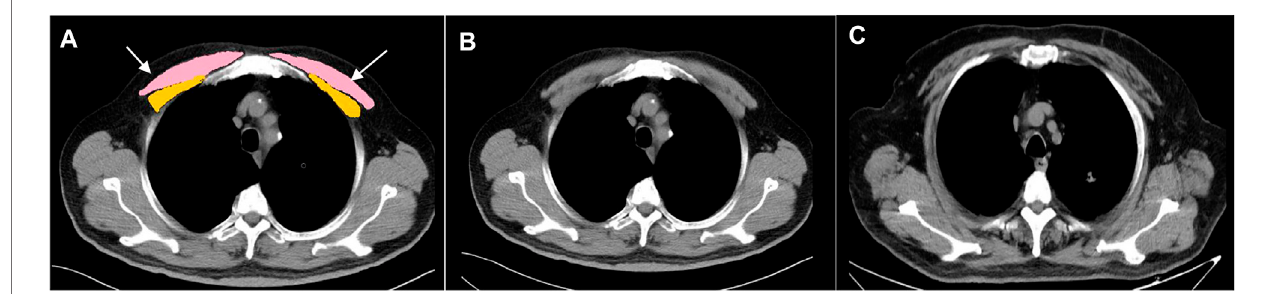
FIGURE 1 | Cross-sectional muscle measurement at the level above the aortic arch. (A) Pectoralis muscles shaded in pink and yellow. (B) Healthy control (male; 65 years-old; BMI: 28.3 kg/m 2 ; PMA: 31.19 cm 2 ; PMT: 46.27HU). (C) Patient with COPD (male; 69 years-old; BMI: 28.03 kg/m 2 ; PMA: 15.27 cm 2 ; PMT: 29.61HU, white arrows point the adipose in fi ltration) PMA, pectoralis muscle cross-sectional area; PMT, pectoralis muscle attenuation; COPD, chronic obstructive pulmonary disease; BMI, body mass index; HU, Houns fi eld